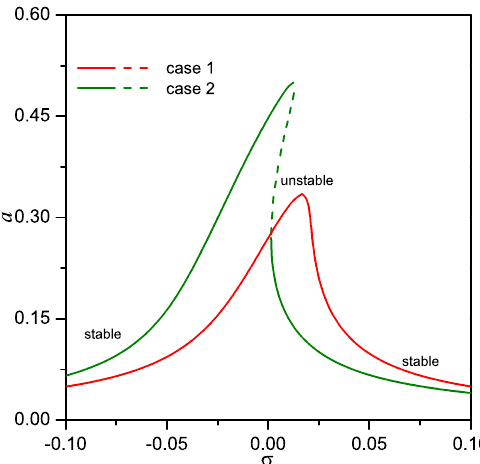
Figure 16. Comparison of frequency response curves of primary resonances response between the time delayed velocity feedback and the time delayed acceleration